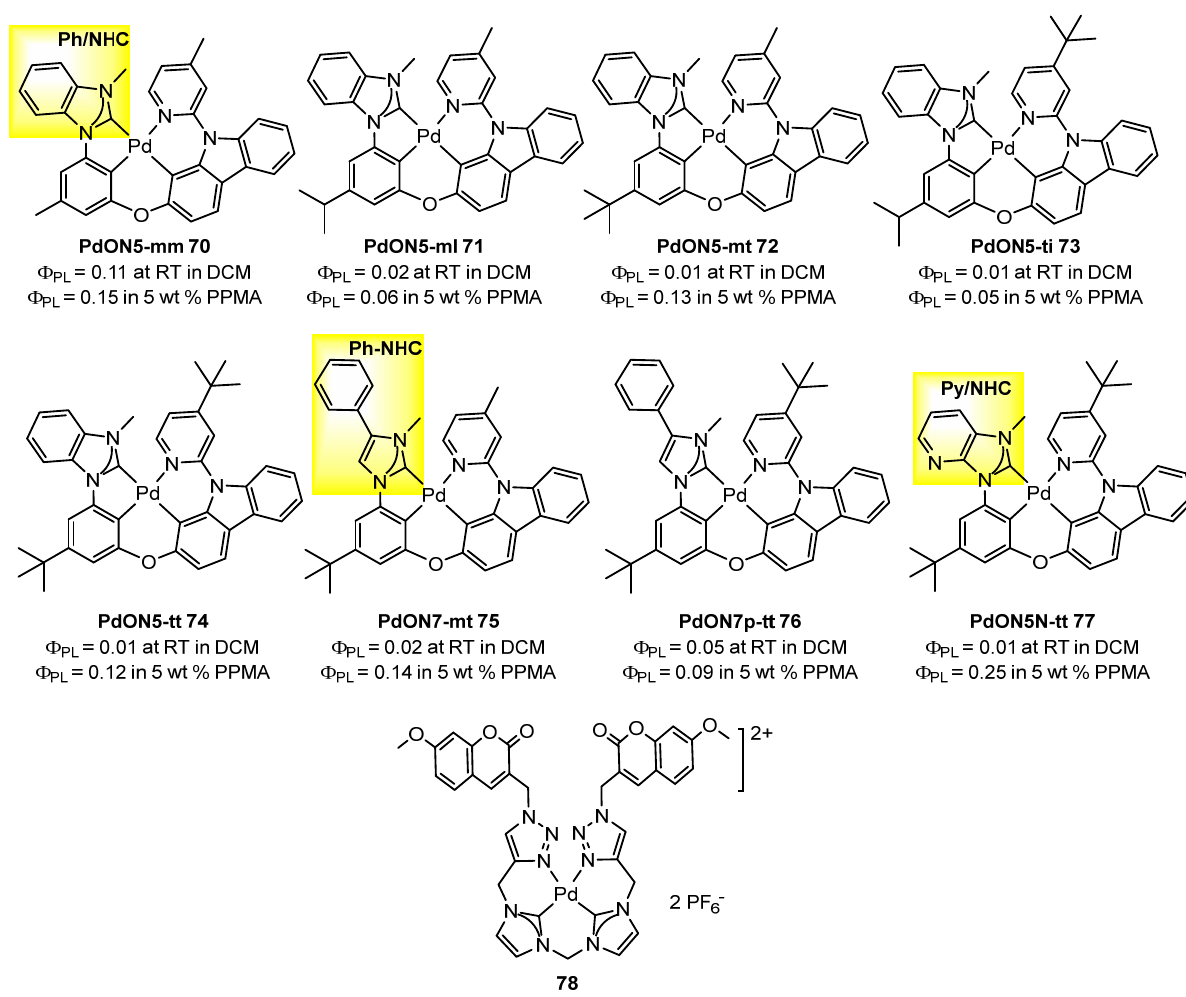
Figure 21. Chemical structures of Pd(II) complexes 70 – 77 with tetradentate ligands, adapted from [86], and 78 , adapted from [87].